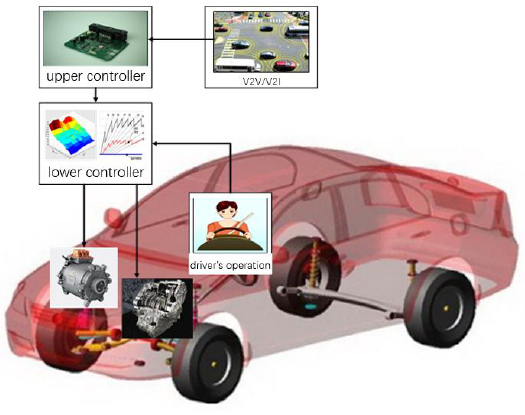
Figure 1. The electric vehicle (EV) control principle.